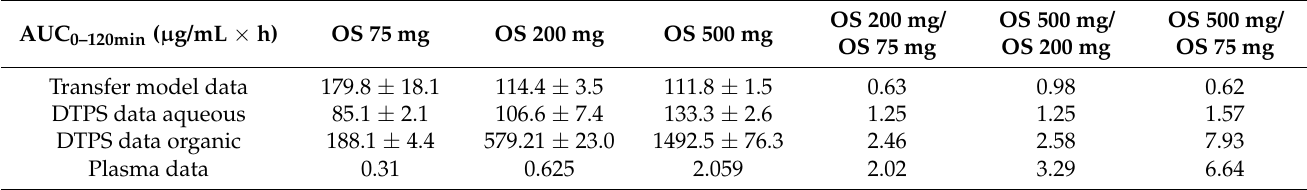
Table 4. Comparison of area under the plasma concentration-time curve vs. area under the concentration-time curve obtained from in vitro transfer model experiments vs. area under the concentration-time curve of the aqueous dissolved amount and the organic partitioned amount obtained from in vitro DTPS experiments. Clinical data represent means ( n = 12 for 75 mg, and n = 6 for 200 and 500